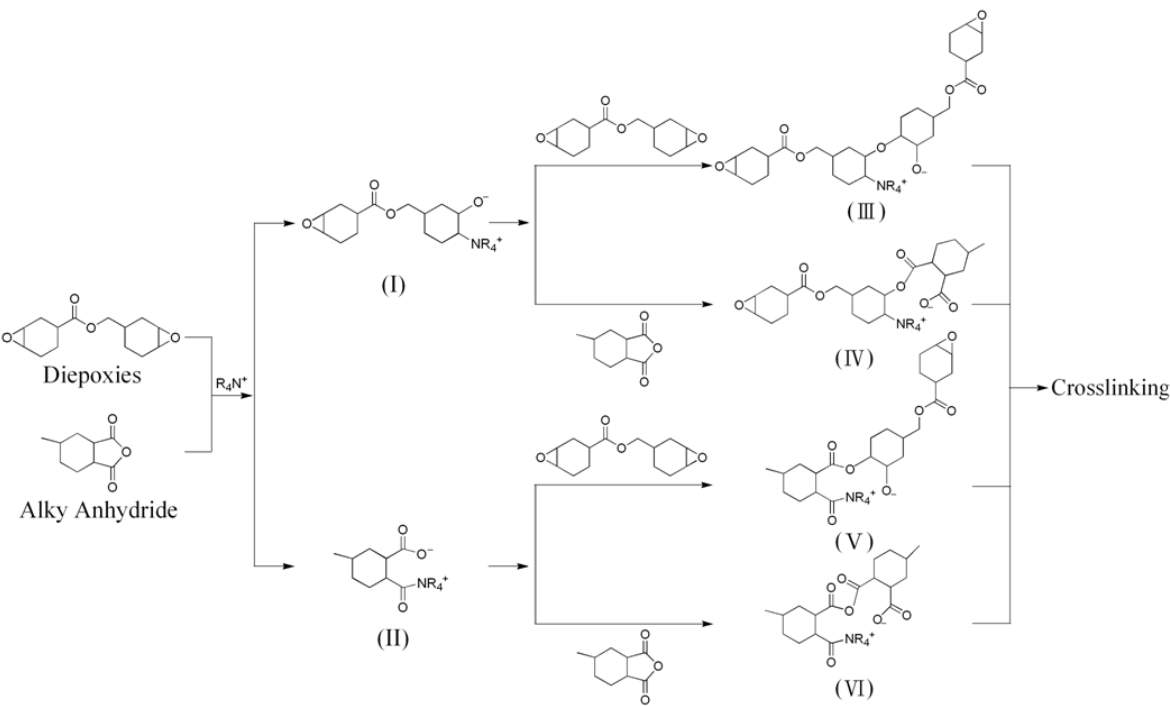
Figure 3. Curing mechanism of anhydride and aliphatic epoxy resin with an amine-salt catalyst (reprinted with permission from reference [77]).